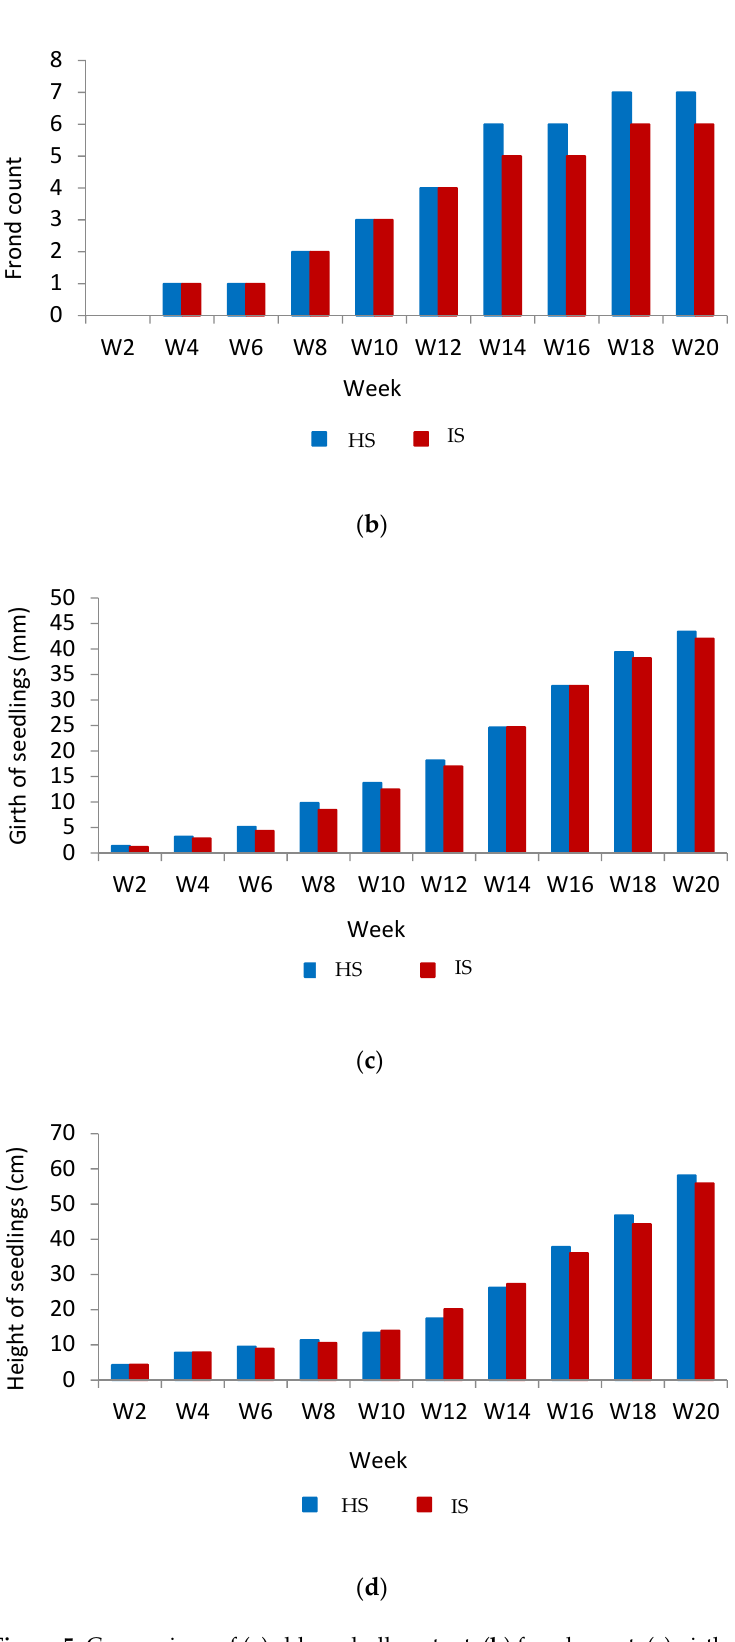
Figure 5. Comparison of ( a ) chlorophyll content, ( b ) frond count, ( c ) girth, and ( d ) height between healthy seedlings (HS) and infected seedlings (IS) for every two weeks of monitoring.